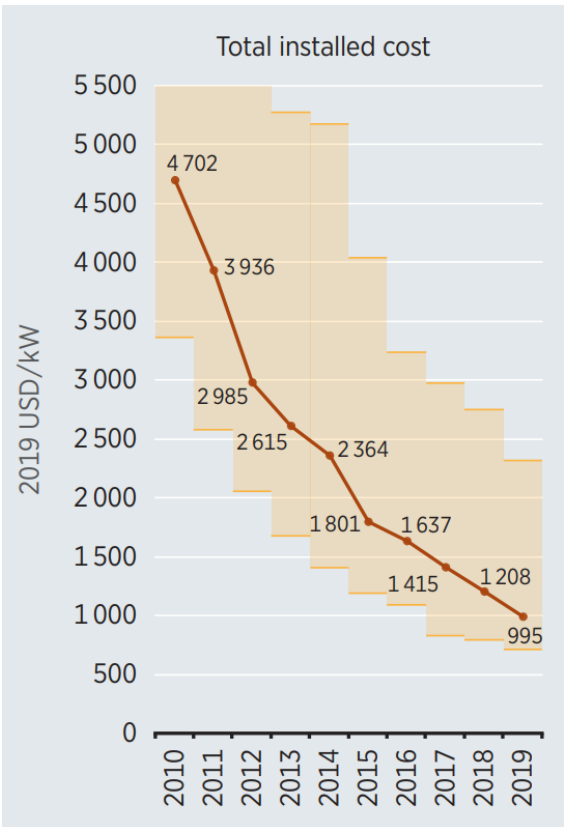
Figure 2. Cost reduction of photovoltaic installations in the United States [3].